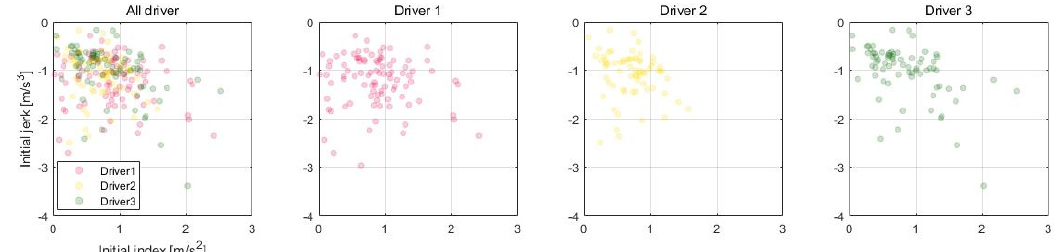
Figure 8. Correlation analysis of the initial jerk.